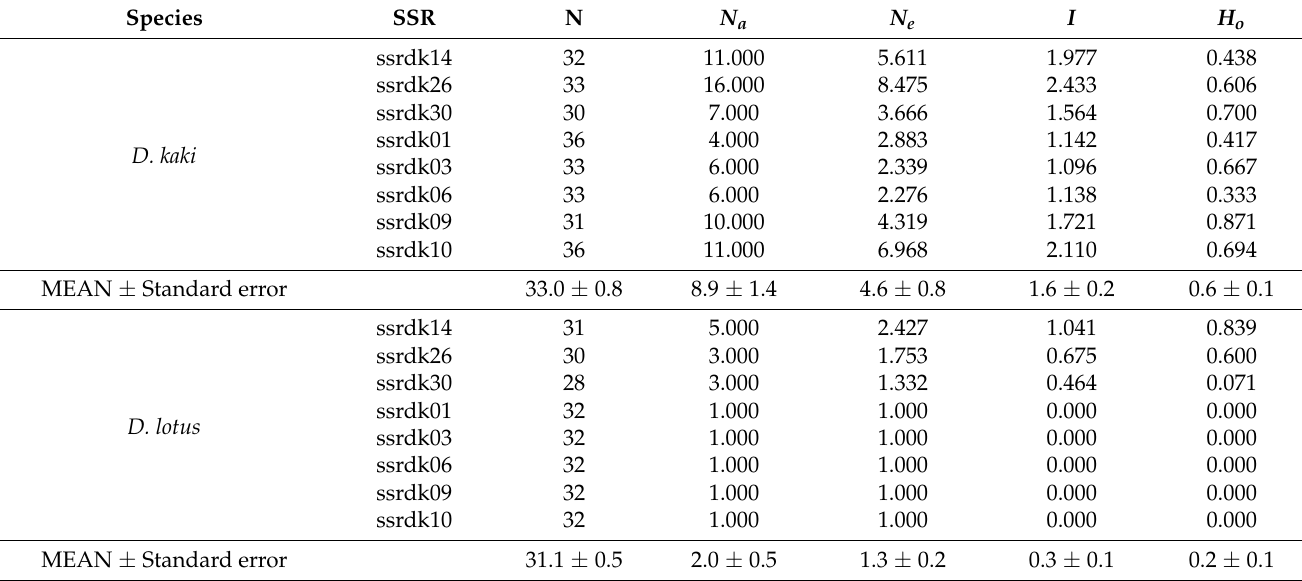
Table 1. Genetic diversity parameters for 8 SSR loci used.